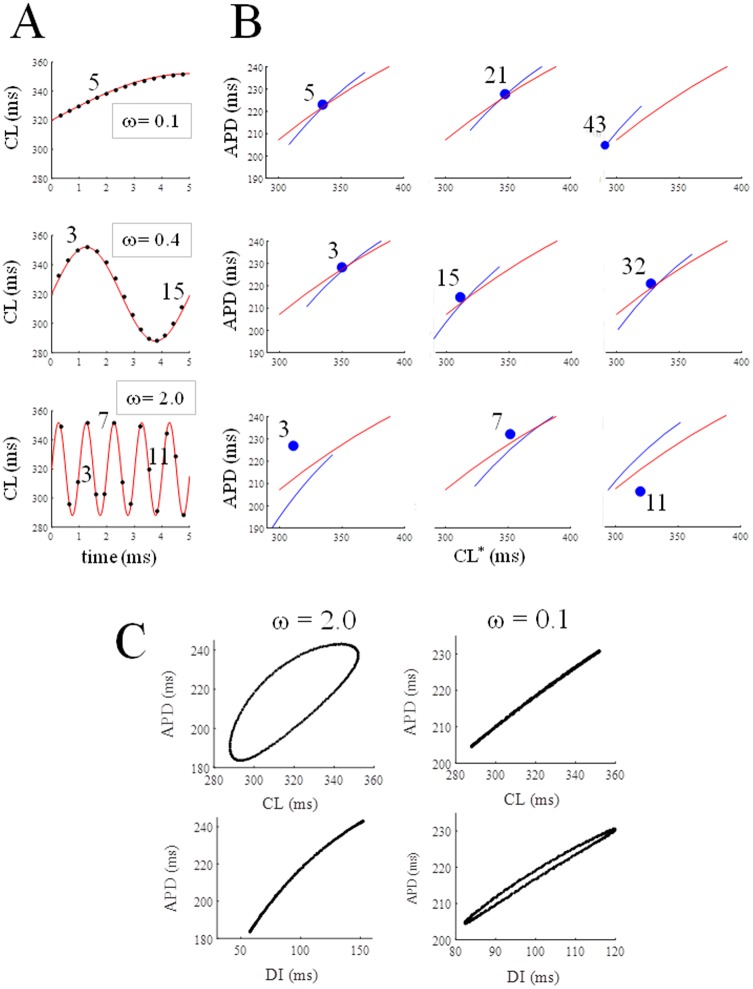
Periodic pacing.(A) Trains of APs were simulated with CL changing periodically (CL* = 320 ms, clv = 32 ms) on a beat-to-beat basis according to Eq 3 and with different values for angular frequency ɷ. (B) The states of 3 beats of each sequence are shown as blue dots. After each of these beats, classical ERCL curves were measured and shown in blue, together with RD (red). (C) Space of sates as dERCL and dERDI for high and low ɷ values.